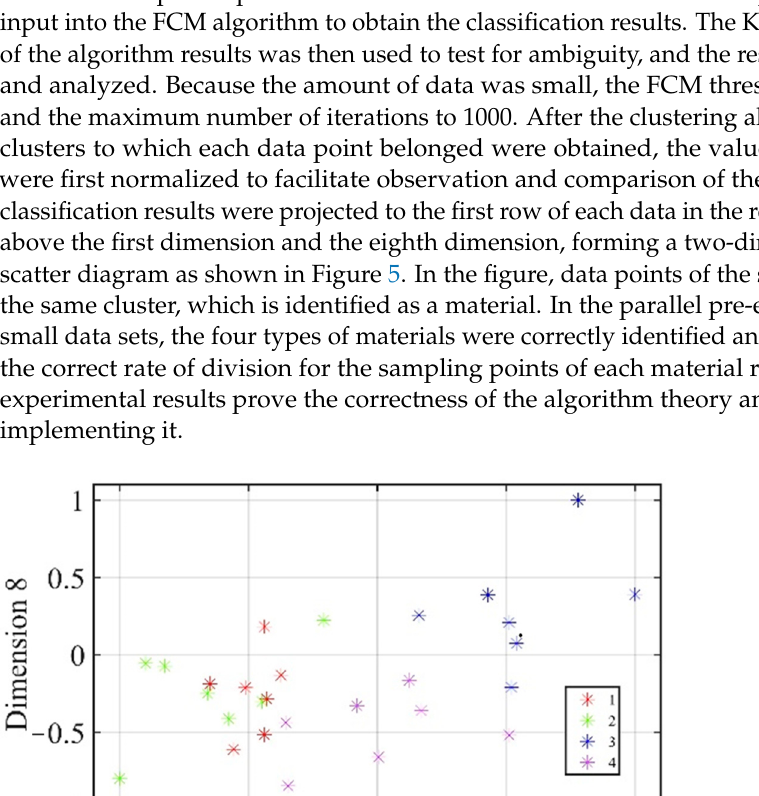
Figure 4. The data contour port at incident angle is 40°.